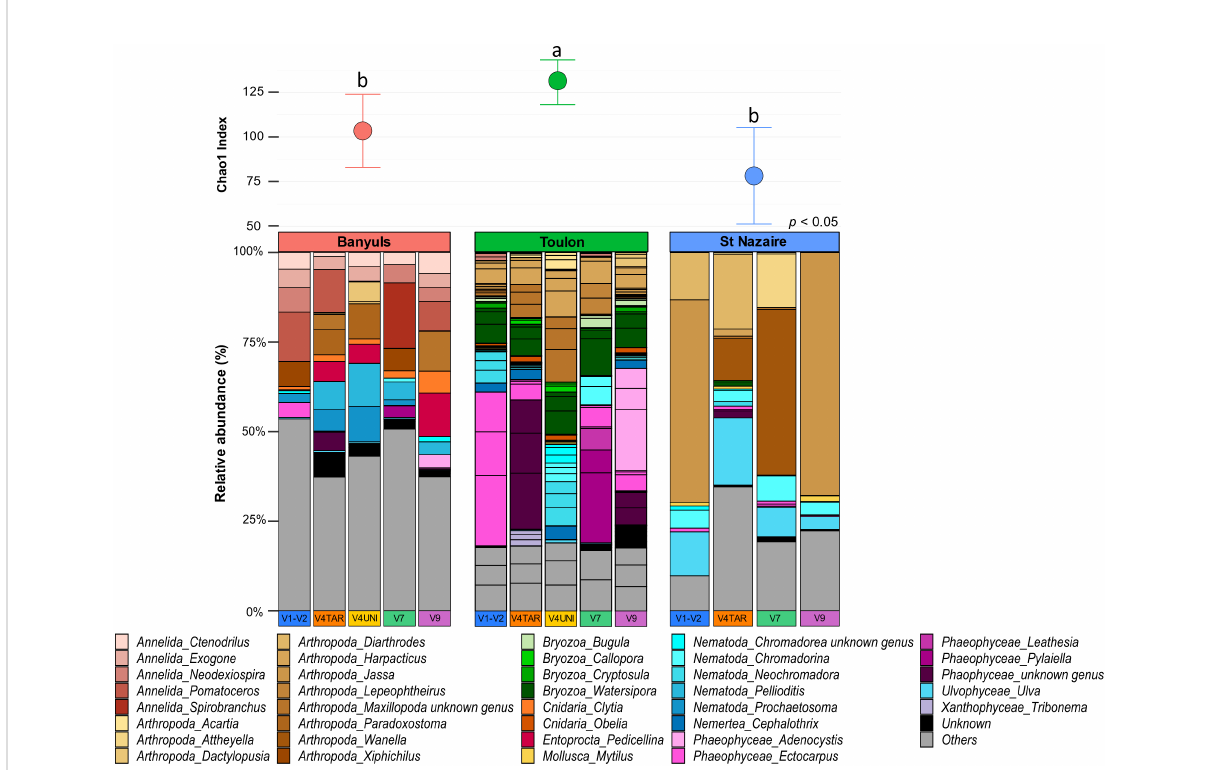
FIGURE 5 Diversity and composition of top eukaryote genera within each site for 18S rDNA gene. Barplots were represented in relative abundance (> 0.1%) of each taxonomic group of eukaryotes. Above the barplot, graph shows chao1 index at each site (Banyuls, Toulon, Saint-Nazaire). Letters above boxplots represent pairwise comparisons between